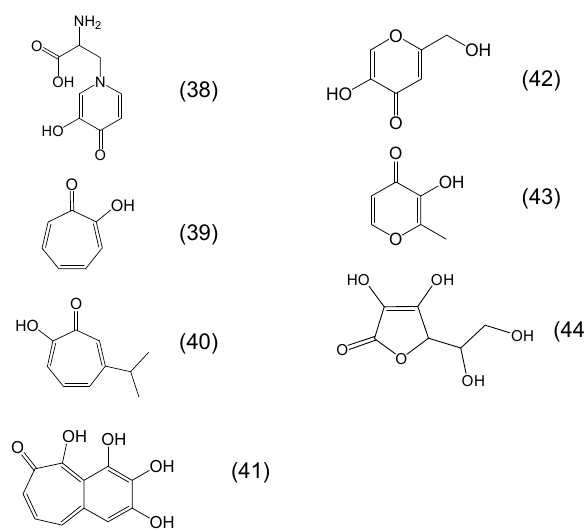
Figure 11. Examples of phytochelators containing the alpha ketohydroxy group in the metal binding site. Mimosine or 2-amino-3-(3-hydroxy-4-oxopyridin-1-yl)propanoic acid ( 38 ), tropolone or 2-hydroxycyclohepta-2,4,6-trien-1-one ( 39 ), hinokitiol or 2-hydroxy-6-propan-2-ylcyclohepta-2,4,6- trien-1-one ( 40 ), purpurogallin or 2,3,4,5-tetrahydroxybenzo[7]annulen-6-one ( 41 ), kojic acid or 5-hydroxy-2-(hydroxymethyl)pyran-4-one ( 42 ), maltol or 3-hydroxy-2-methylpyran-4-one ( 43